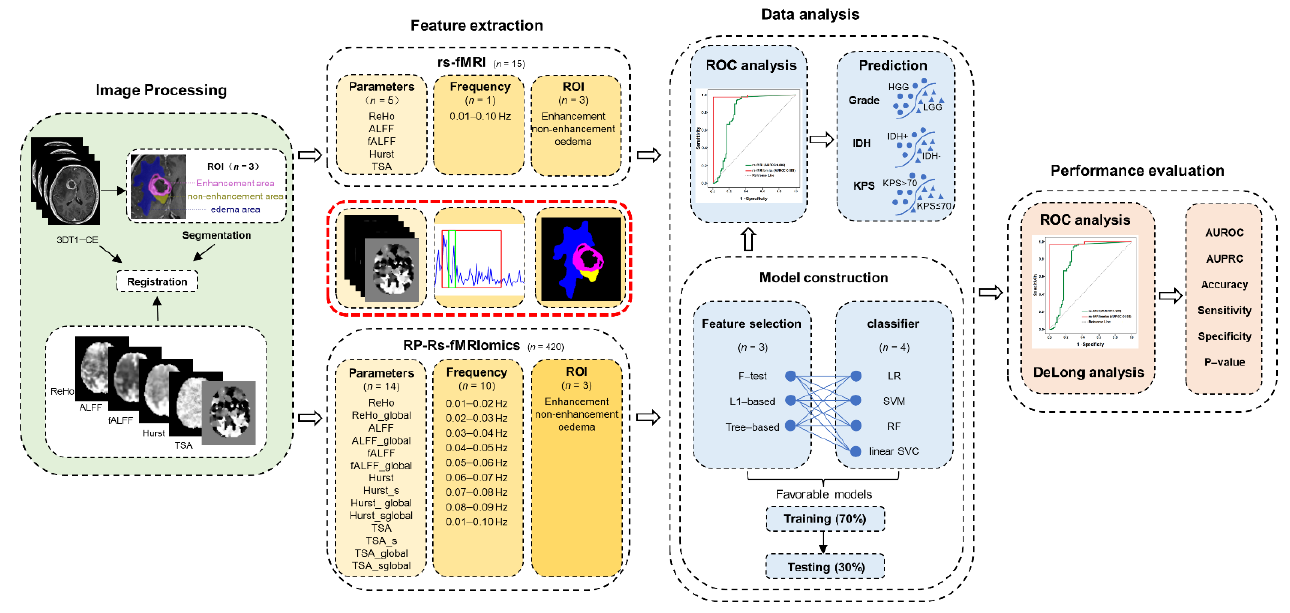
Figure 2. The whole workflow of this study. RP-Rs-fMRIomics models were constructed for predicting glioma grade, isocitrate dehydrogenase status and Karnofsky Performance Status scores, based on the features extracted through measuring 14 regional parameters of rs-fMRI in 10 specific narrow frequency bins and 3 parts of gliomas. Then, three radiomics feature selections and four classifiers were implemented. The diagnostic performances of RP-Rs-fMRIomics models were compared with conventional single-parameter fMRI analysis using Delong’s